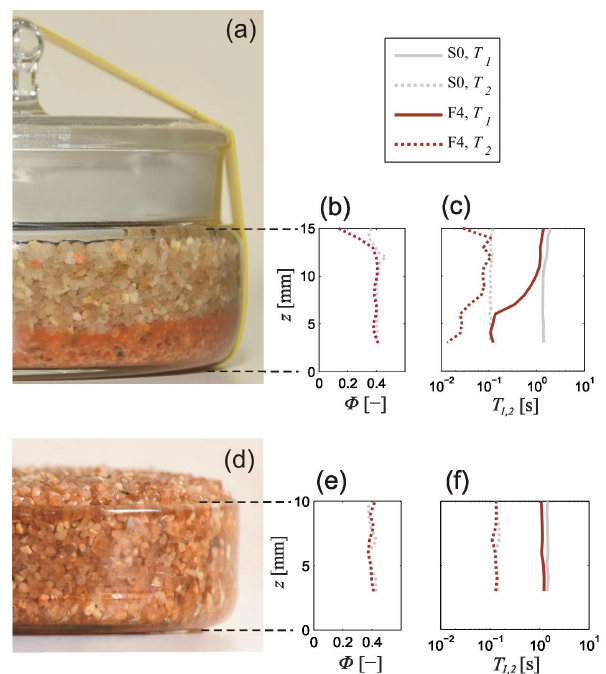
Figure 5. (a) Sample F4 after chemical treatment and precipitation of ferrihydrite particles at the bottom of the sample holder. Panels (b) and (c) : vertical distributions of corresponding porosities (cid:56) and mean relaxation times T 1 and T 2 , compared to those of untreated sand S0. Panels (d) – (f) : sample F4 after homogenisation and cor- responding distributions of (cid:56) and T 1 , 2